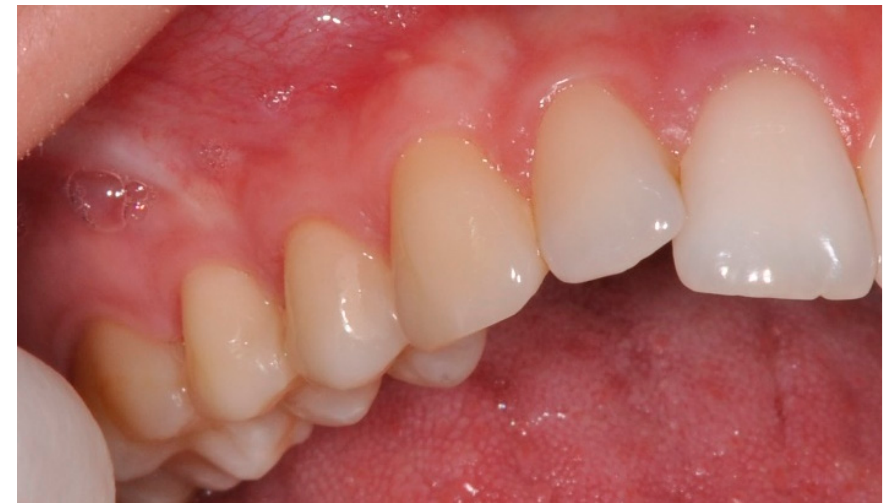
Figure 8. Clinical situation 2 years after surgery with complete root coverage presented.